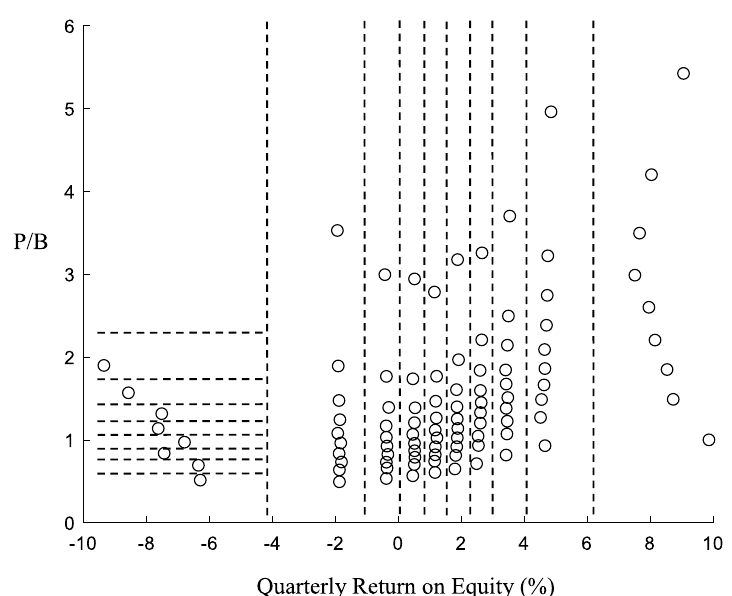
Fig. 1 The stocks are sorted into deciles according to the ROE of each quarter. Each decile is sorted into deciles according to the P/B at the end of the quarter. Then a total of 100 investment portfolios are obtained